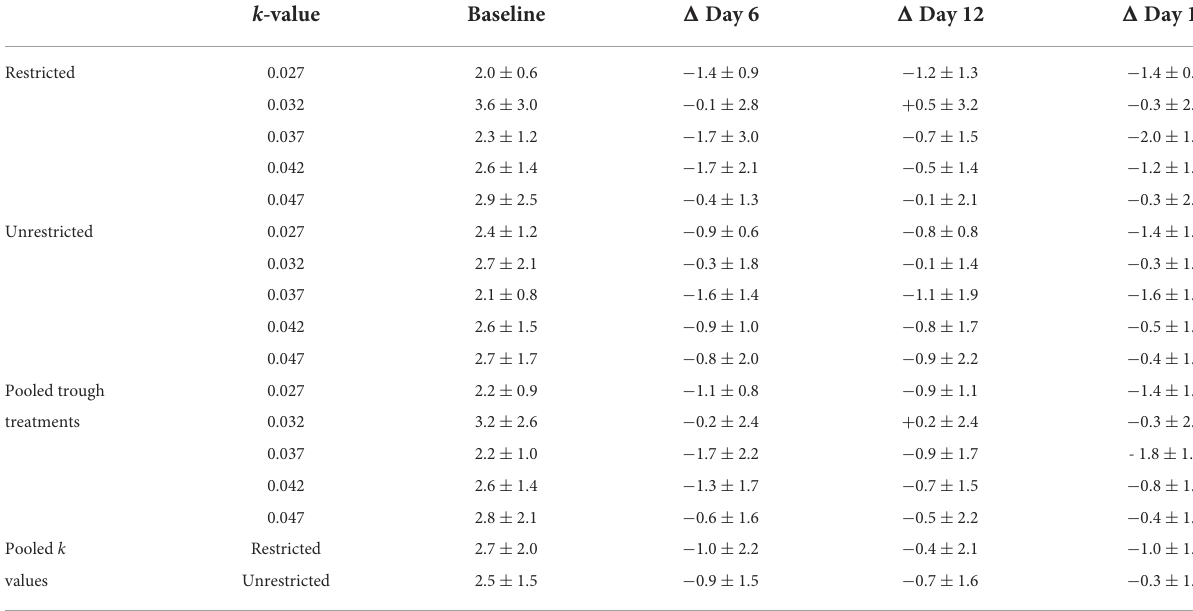
TABLE 7 Baseline FGCM concentrations (in ng/g DM) and the means ± standard deviations of each sheep’s change ( 1 ) on each sampling day relative to its baseline (in ng/g DM). k